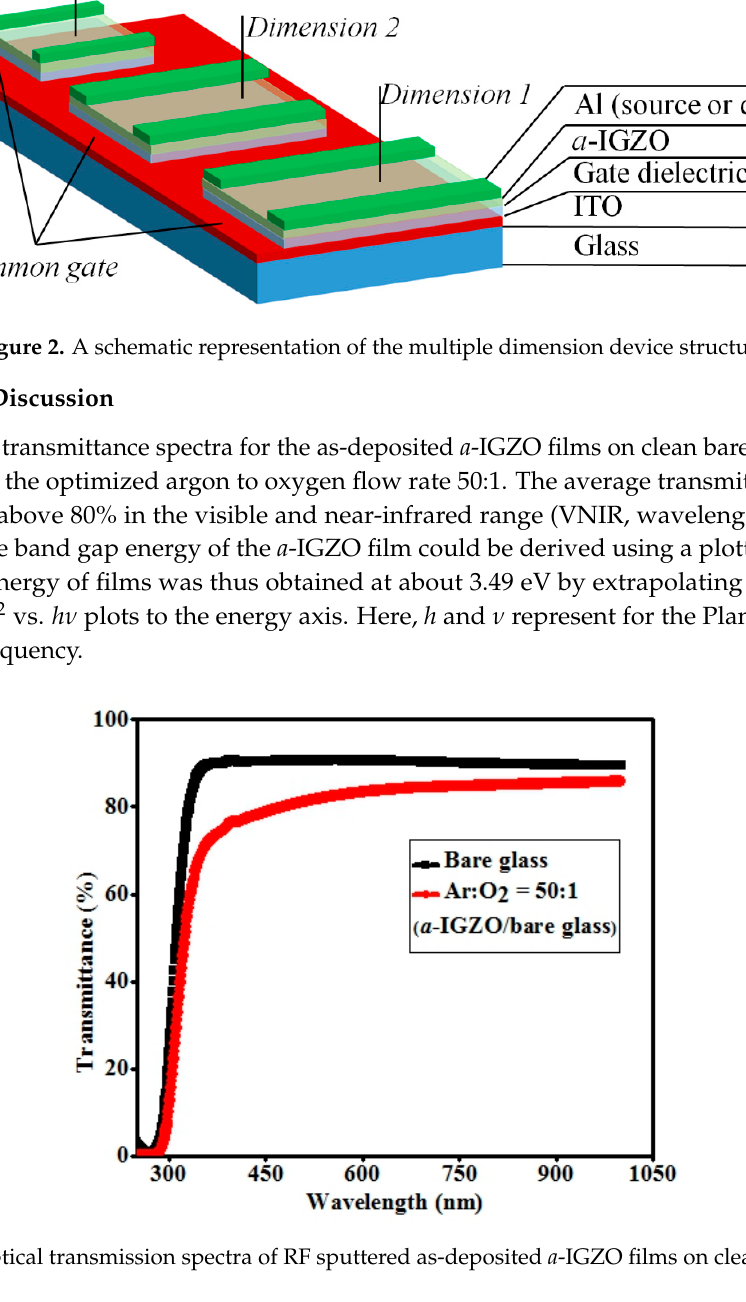
Figure 2. A schematic representation of the multiple dimension device structure.